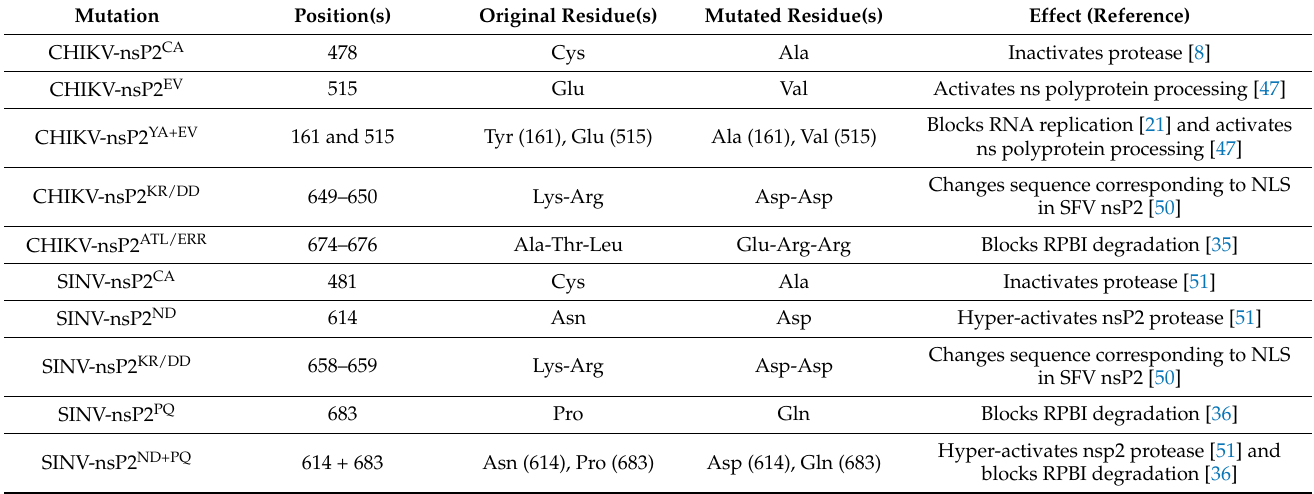
Table 1. Mutations introduced into nsP2 of CHIKV and